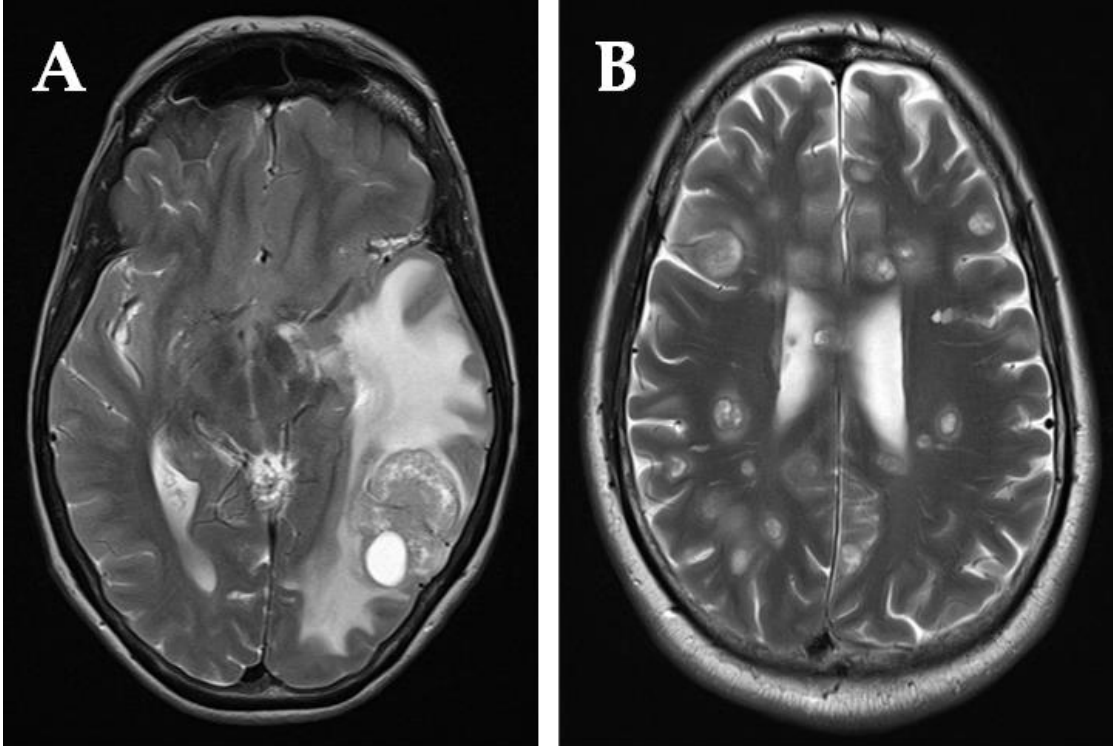
Figure 2. ( A ): T2 weighted magnetic resonance (MR) image of a solitary parietal lobe brain metastasis (BM) and vasogenic oedema; female, 67 years old, with grade 2 metastatic small bowel NEN. Patient was treated with high-dose steroids and underwent surgical resection of the solitary BM. ( B ): T2 weighted MR image of diffuse multiple BMs within cerebrum; male, 55 years old, with G3 metastatic NEC of unknown primary. Patient treated with high-dose steroids and best supportive